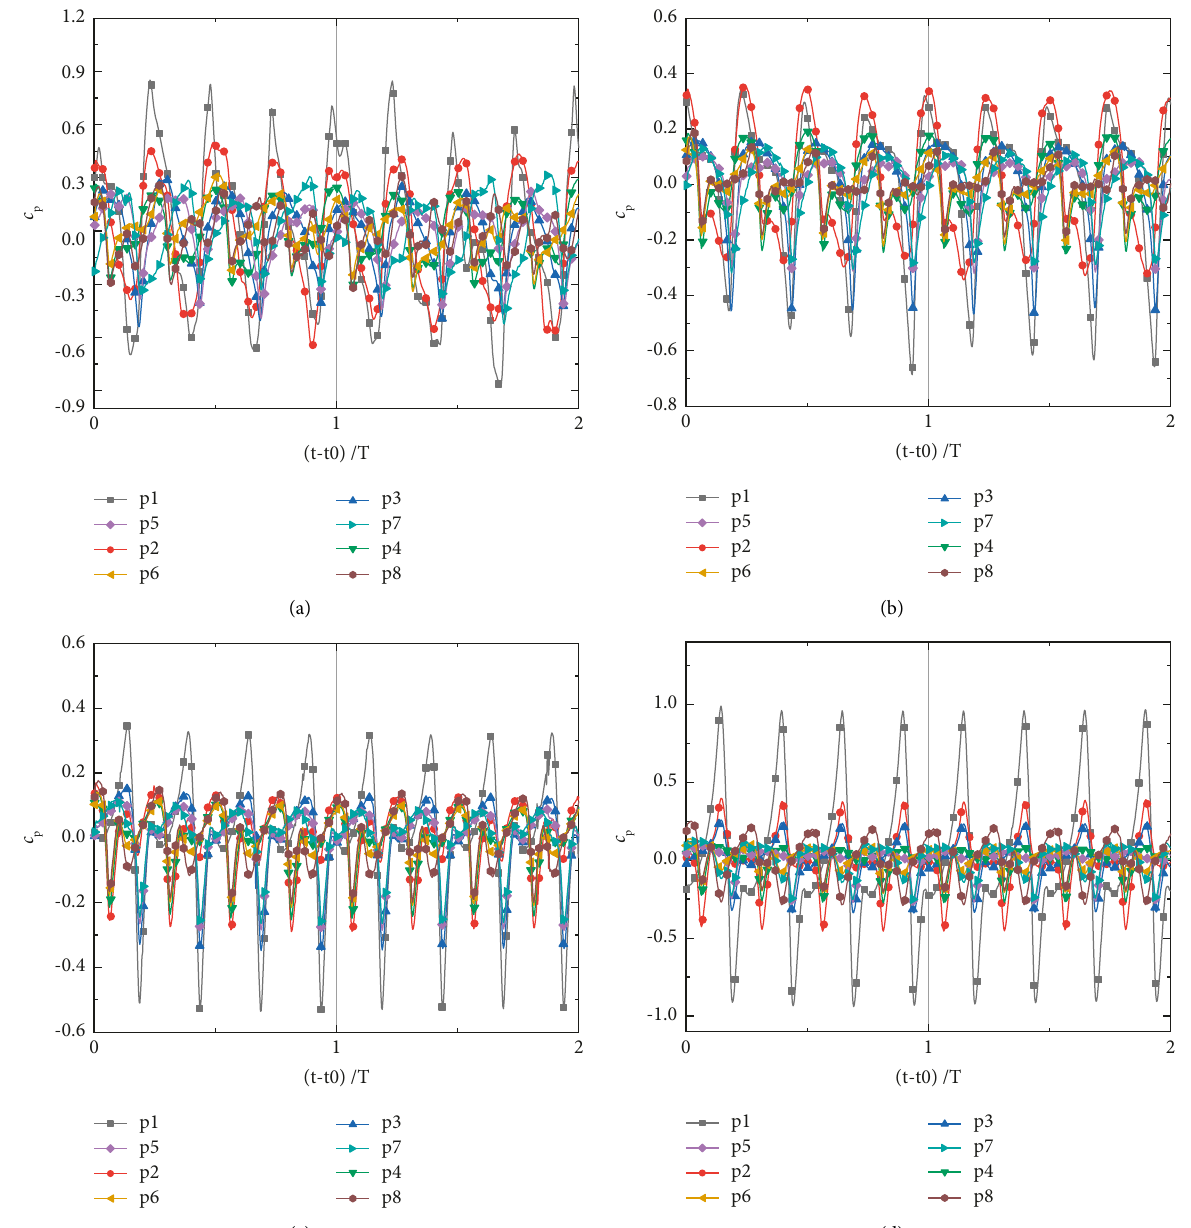
Figure 8: Unsteady pressure fluctuations at monitoring points. (a) 0.4 Q